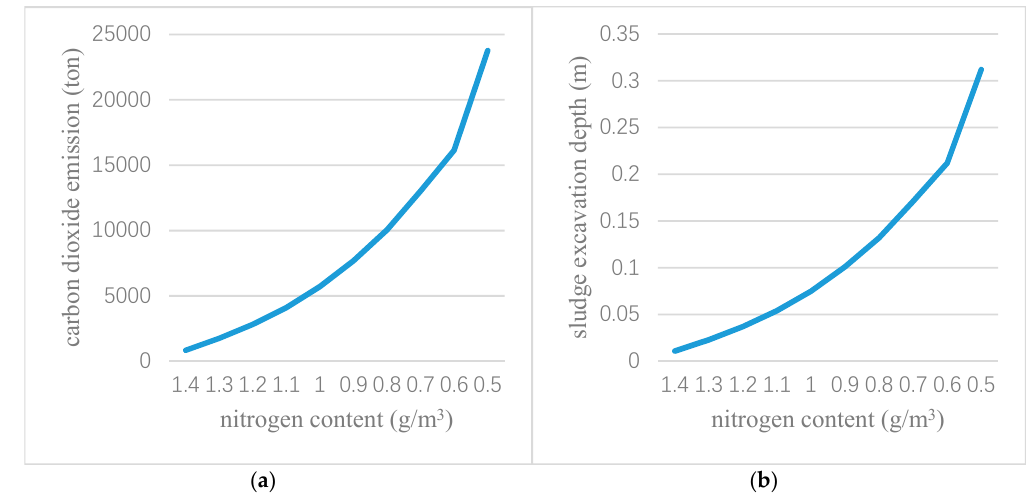
Processes 2021 , 9 , x FOR PEER REVIEW Figure 3. Relationship between nitrogen content and carbon dioxide emission ( a ) and sludge excavation depth ( b ).